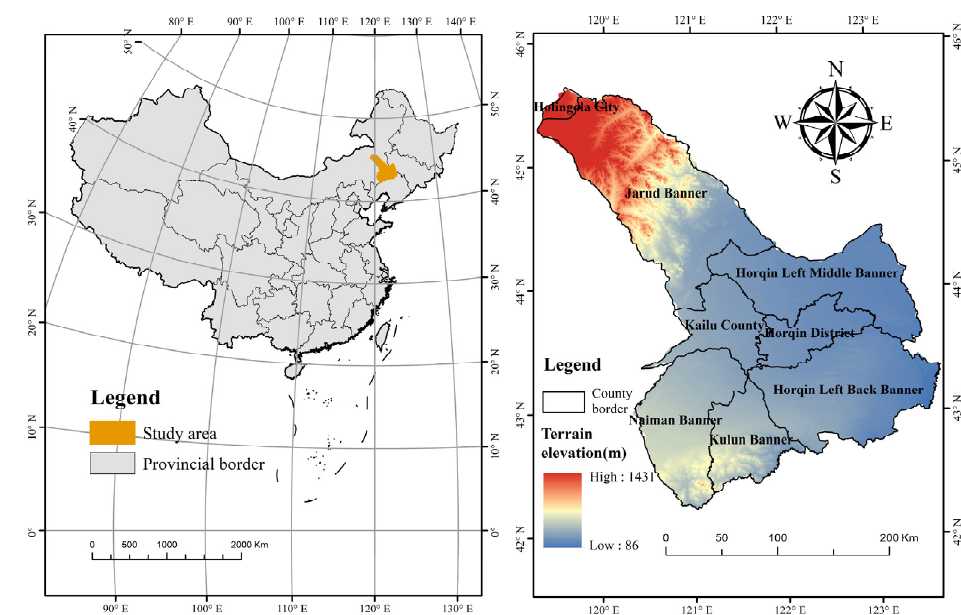
Figure 2. Location of the study area.